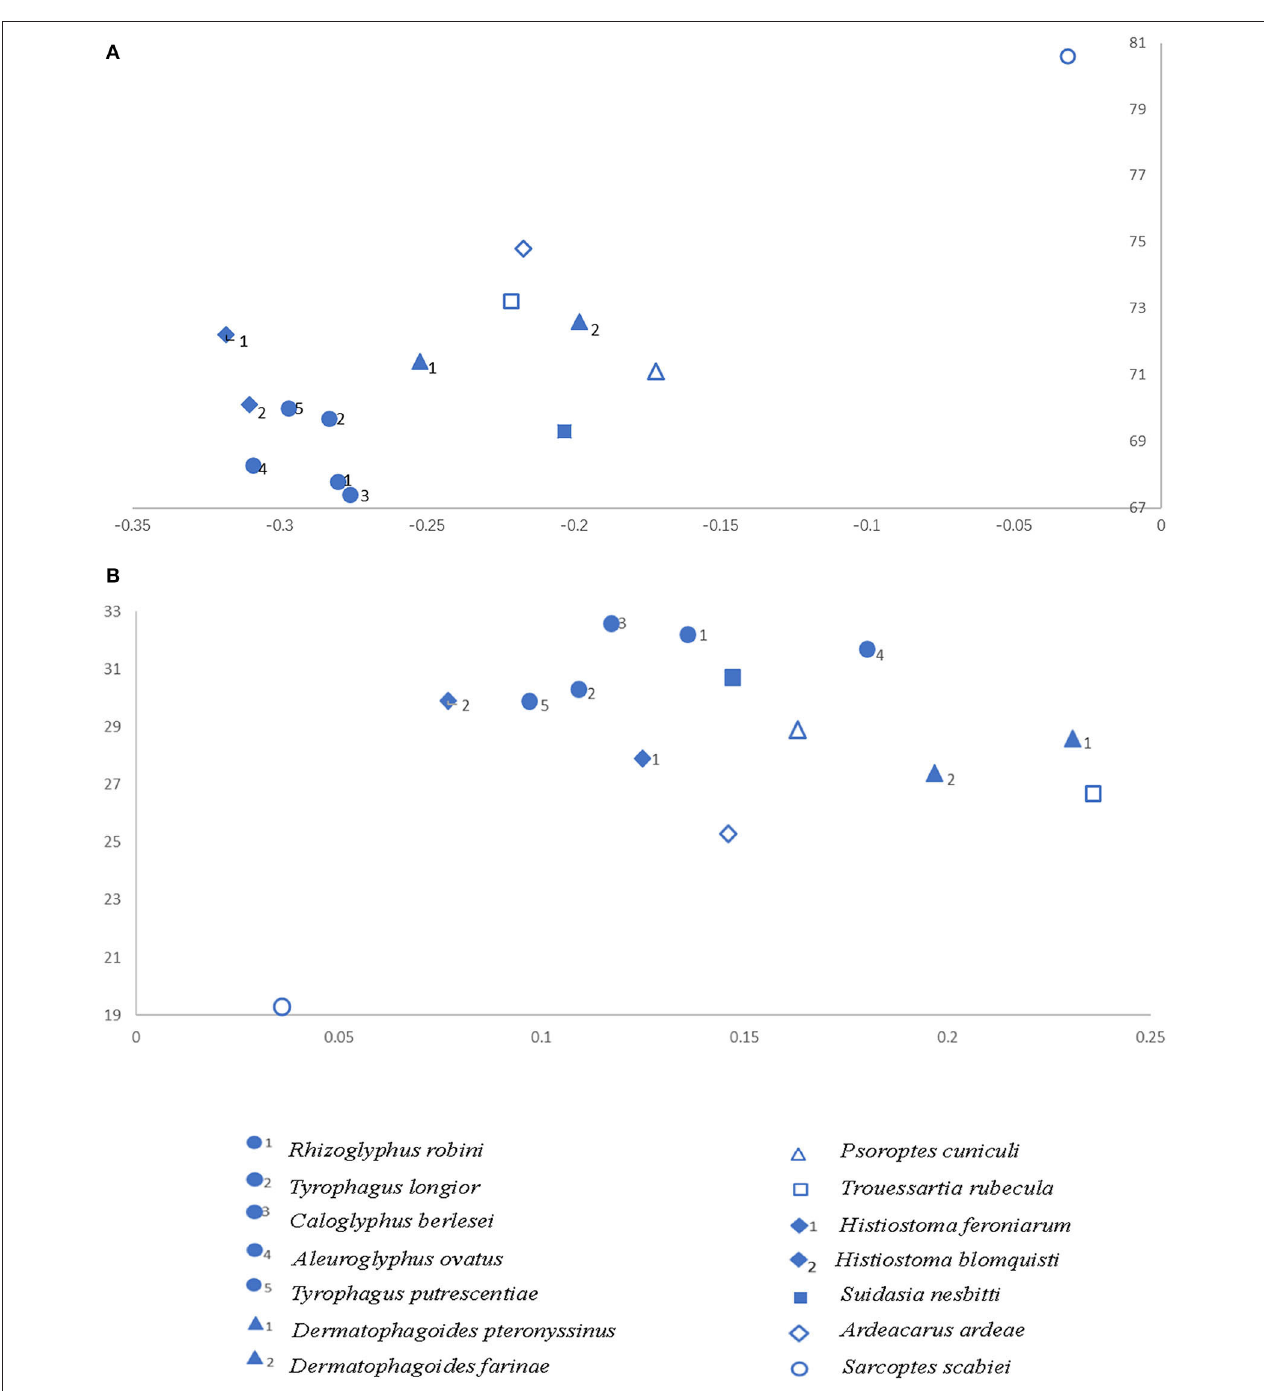
FIGURE 1 | AT% vs. AT-skew and GC% vs. GC-skew in the 14 Astigmata mitochondrial genomes. Values are calculated on J-strands for full length mitochondrial genomes. X-axis shows level of nucleotide skew and the Y-axis indicates the nucleotide percentages. (A) AT% vs. AT-skew. (B) GC% vs. GC-skew.